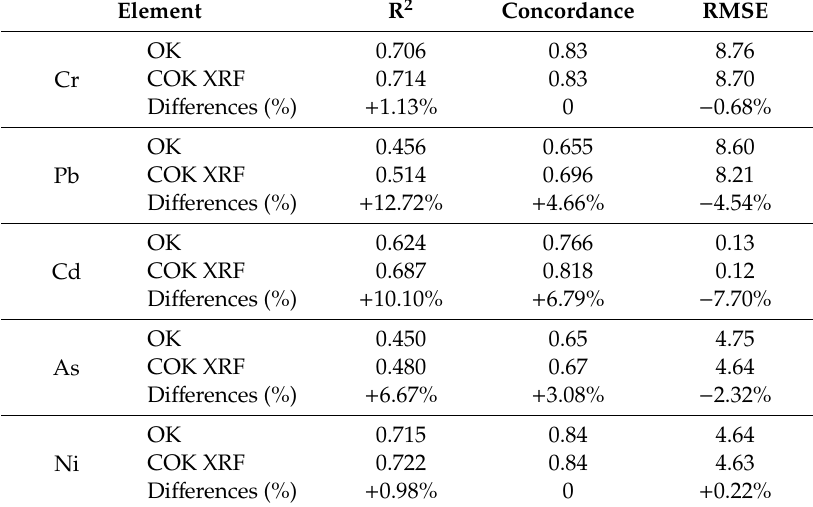
Table 4. Comparison of model accuracy of ordinary kriging (OK) and co-ordinary kriging (COK) for di ff erent heavy metals. Element